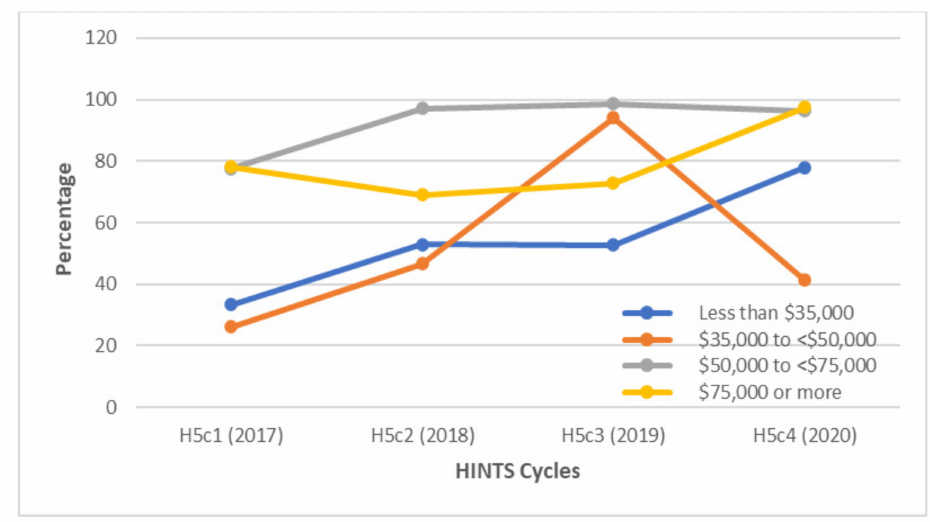
Figure 4. Awareness of HPV among gay and bisexual males according to income levels between 2017 and 2020. A higher percentage of GBM with incomes above $50,000 were aware of HPV compared to GBM with incomes below $50,000 in 2017, 2018, and 2020.